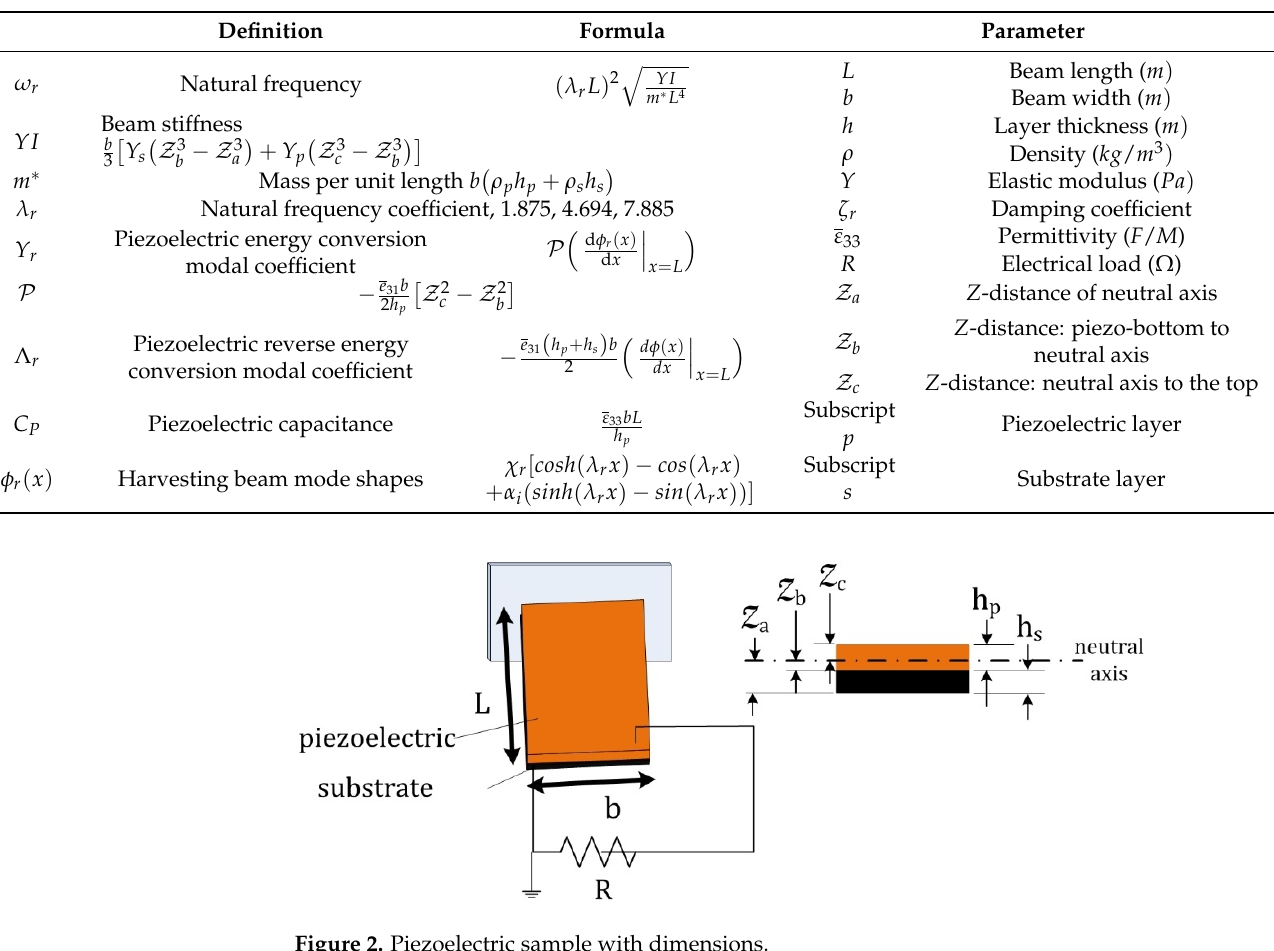
Table 1. Parameters of the unimorph harvesting model.